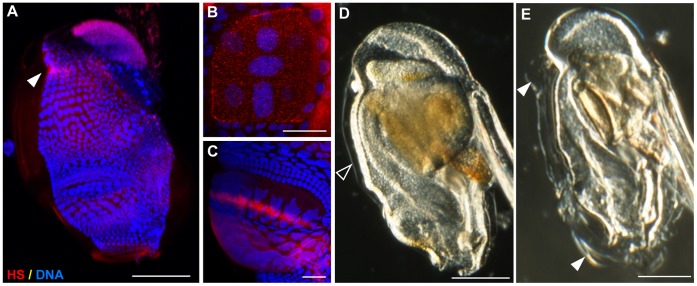
Arrest of pre-house rudiment inflation in the presence of sodium chlorate.(A,B,C) Localization of heparin/heparan sulfate (HS) on pre-house rudiments. Though generally present throughout the rudiment, more intense staining was detected in a posterior dorsal region (A, filled arrowhead), a region in which pre-house inflation is normally initiated, and corresponding spatially to the upper blister observed during failed inflation in E. HS staining was also enhanced along mesh lines of the nascent if (inlet filter) produced above the Eisen region (B). HS staining was also enhanced above the anterior and giant Fol regions (C) responsible for production of the fcf (food-concentrating filter), and corresponding spatially to the lower blister observed during failed inflation in E. (D,E) Day-5 animals were cultured at room temperature in seawater in the absence (D) and presence (E) of 3 mM sodium chlorate, an inhibitor of glycosaminoglycan sulfation, for 9 h. The animals are oriented anterior (mouth) to bottom, posterior (gonad) to top, and ventral (tail) to right. Pre-house rudiments stacked on the trunk of the animals are indicated with arrowheads. When glycosaminoglycan sulfation was reduced, only partial inflation of house rudiments (open arrowhead, (D) was observed in localized blisters (filled arrowheads, E). Scale bars: 200 µm for A, D and E, and 50 µm for B and C.